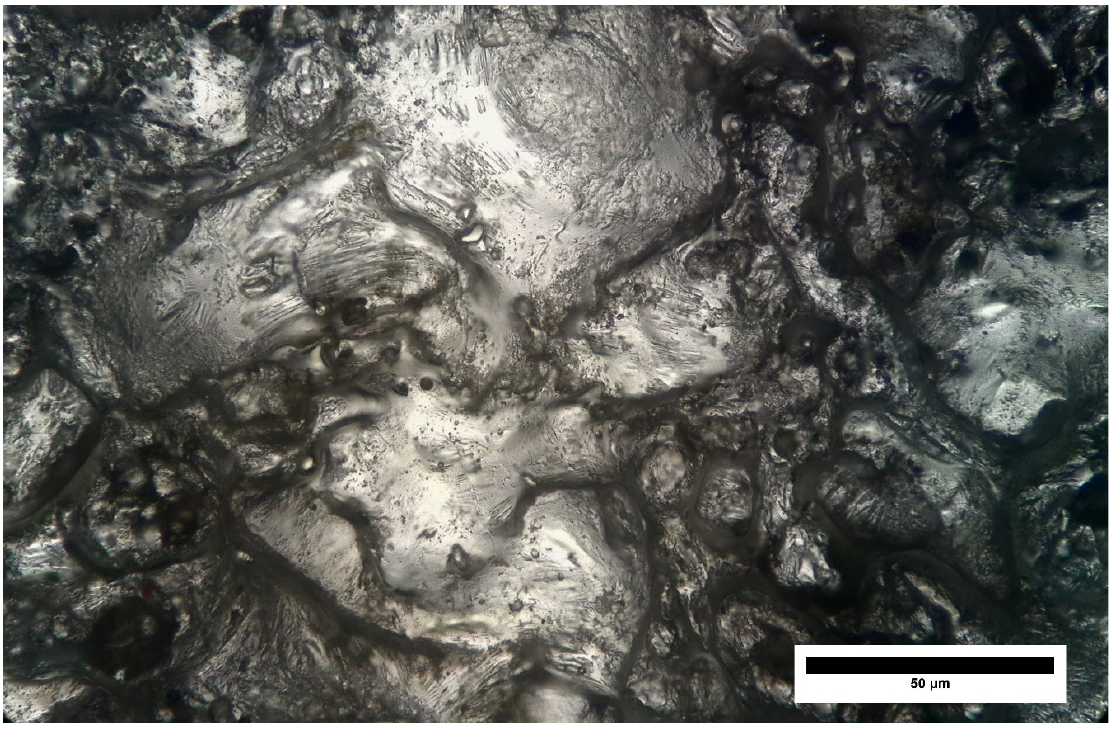
Figure 6. Details of the machined surface for I P = 15 A and T on 200 µ s.